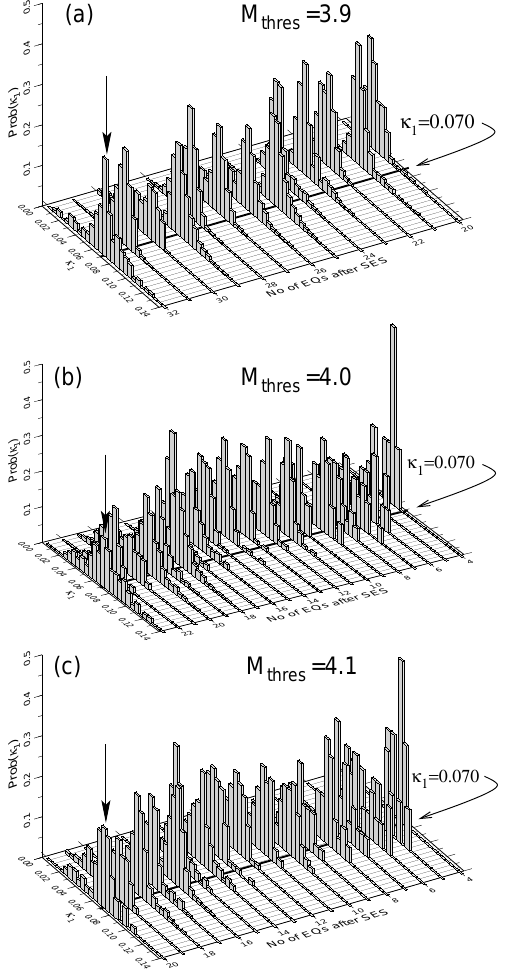
Fig. A1. The probability Prob( κ 1 ) versus κ 1 of the seismicity with magnitude threshold M thres = 3 . 9 (a) , M thres = 4 . 0 (b) and M thres = 4 . 1 (c) within the shaded area shown in Fig. 1a subse- quent to the SES activity recorded at PIR during 29 February to 2 March 2008, see the third channel in Fig. 1b. The vertical arrows mark the maxima of Prob( κ 1 ) versus κ 1 at κ 1 ≈ 0.070 that occurred at 23:26UT on 27 May 2008 (practically 28 May) and has been fol- lowed by the M w = 6 . 4 on 8 June 2008. Taken from Sarlis et al.